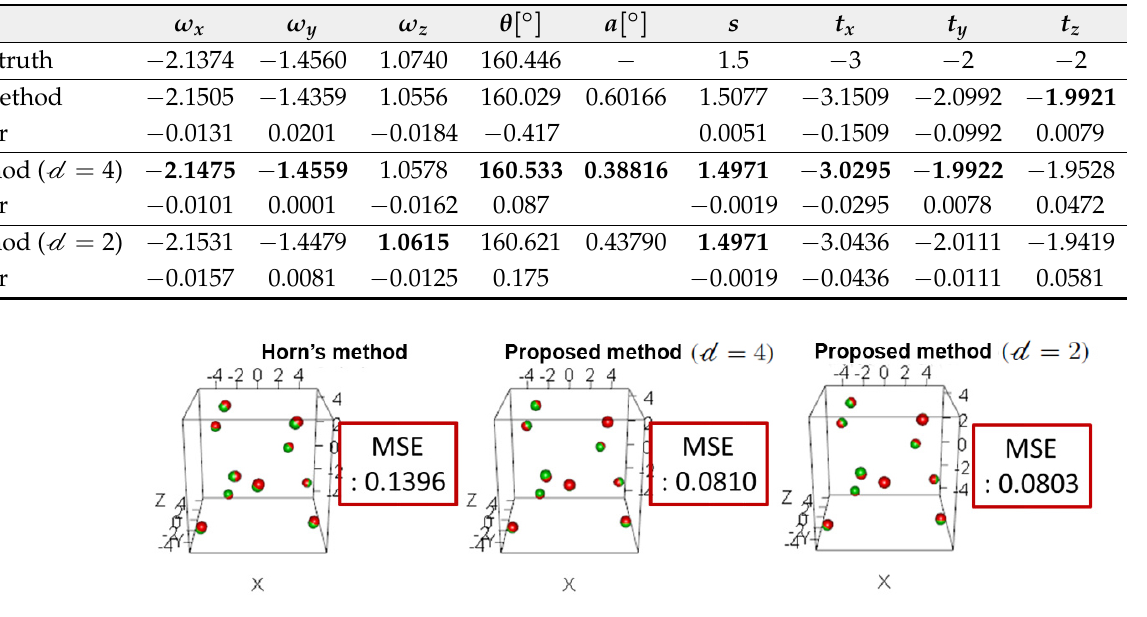
Table 2. Comparison of the relative pose estimation methods—second set of points.